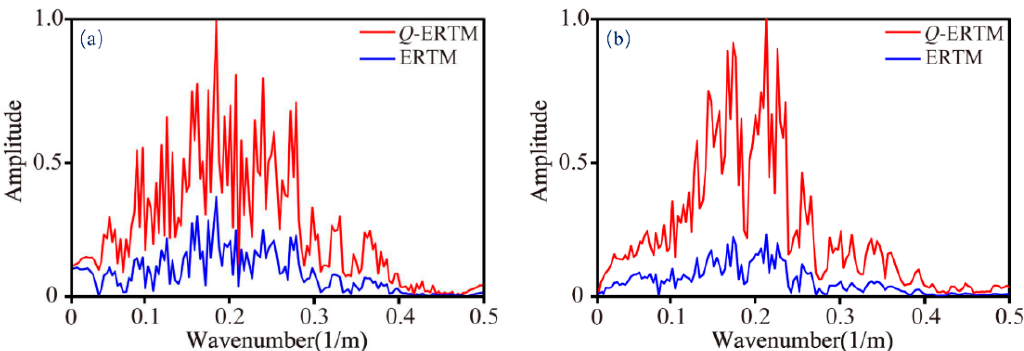
Figure 12. PP-images of the field data obtained by ( a ) ERTM method (without Q -compensation), ( b ) the proposed Q -ERTM scheme; PS − images of the field data obtained by ( c ) ERTM method (without Q -compensation), ( d ) the proposed Q -ERTM scheme.